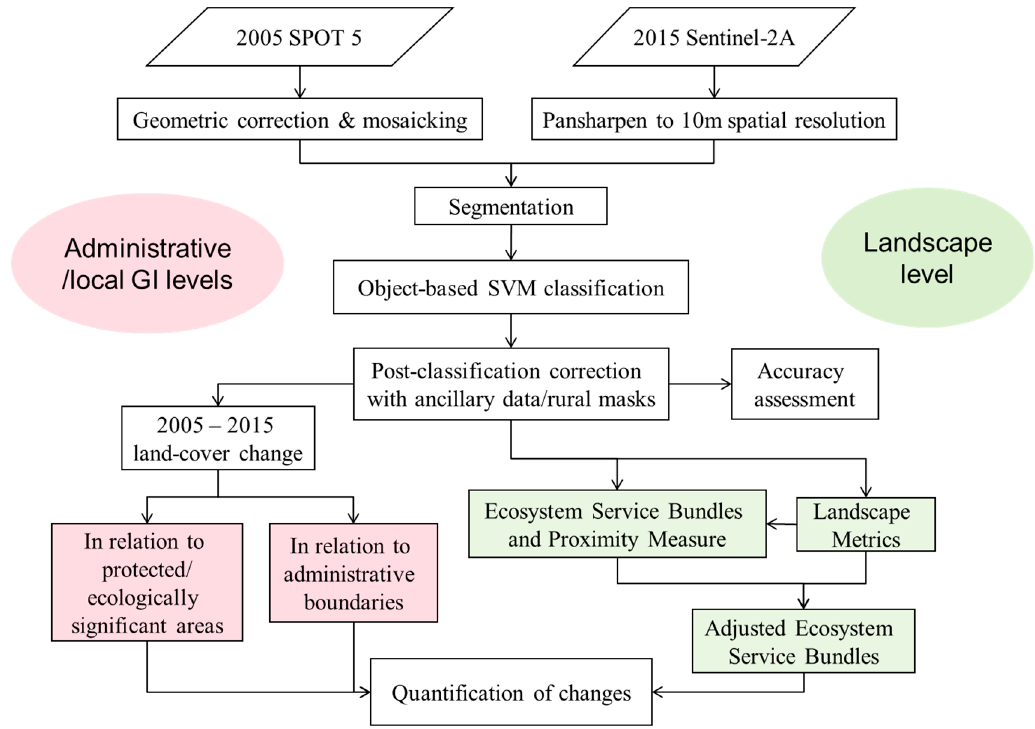
Figure 2. Methodology flowchart detailing the major steps in the research. Steps relating directly to either the landscape or administrative/local level of analysis are highlighted.